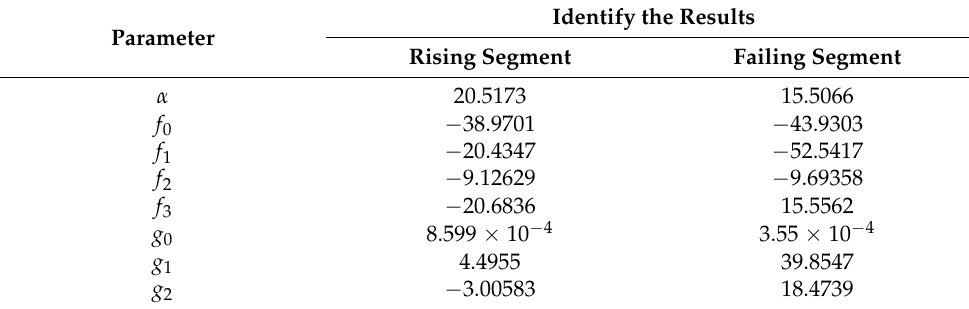
Table 3. Artificial fish swarm algorithm segmentation identification model